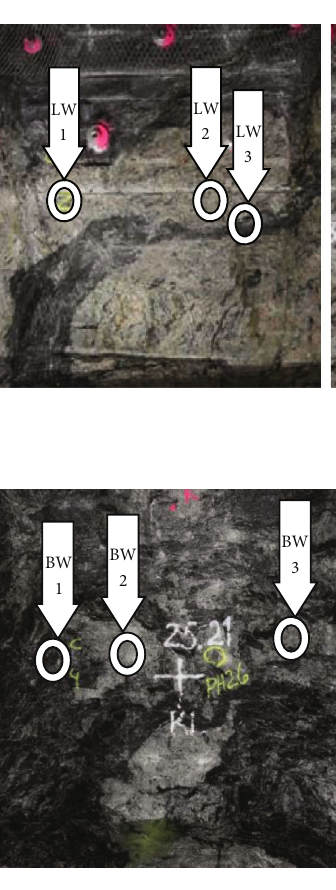
Figure 7: Demo 3 back